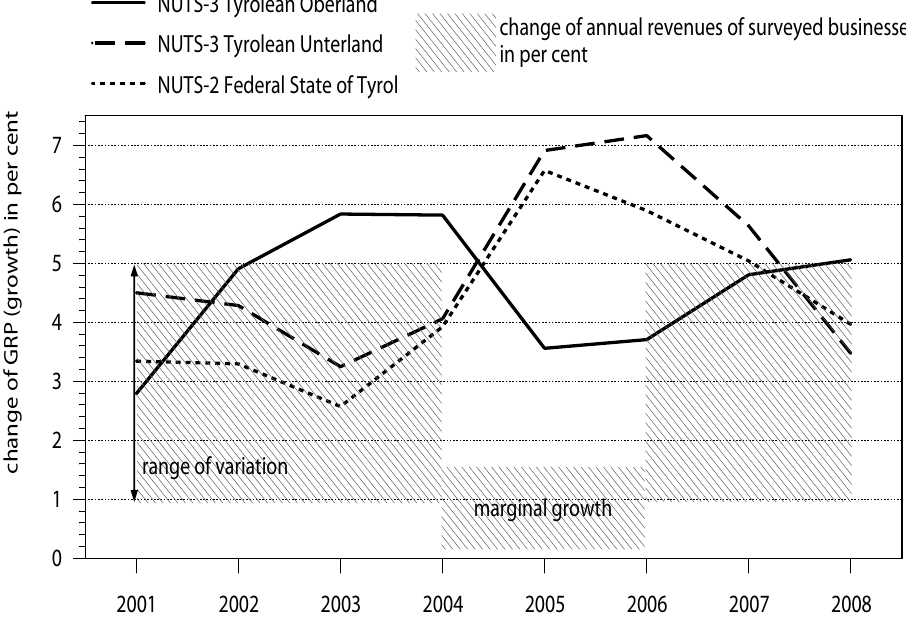
Fig. 10. Annual economic growth at NUTS-2/NUTS-3 level and change in annual revenues of surveyed businesses in % from 2001 to 2008, n = 125; source: Statistics Austria,